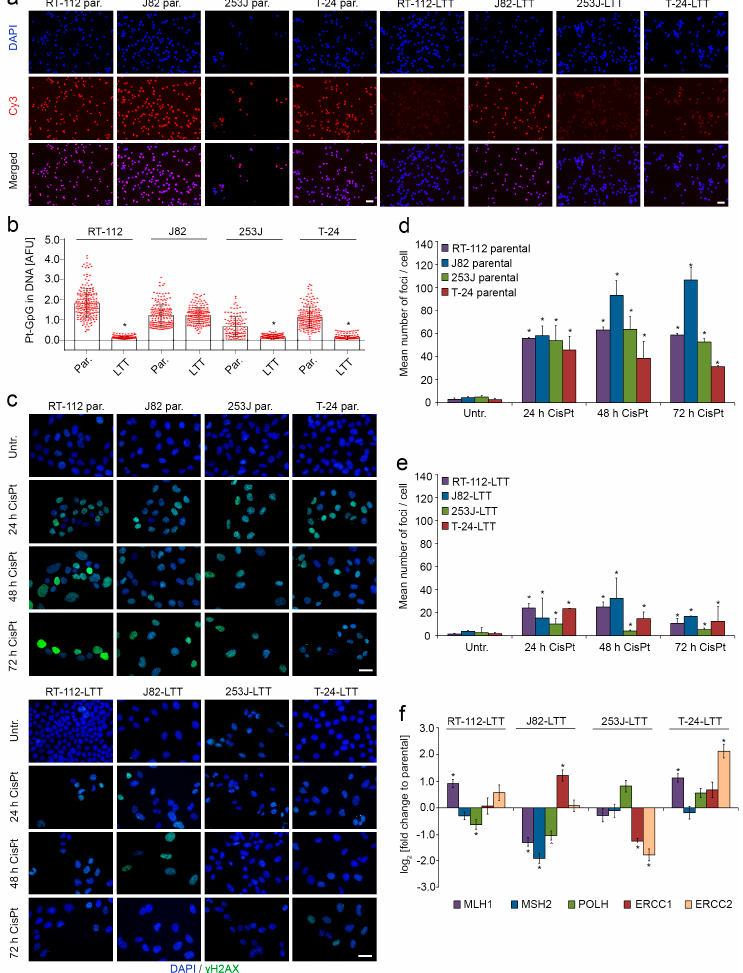
Figure 3. DNA-cisplatin adduct formation and extent of DNA damage are reduced in LTTs. ( a ) Representative immunofluorescence staining for Pt-adducts in parental UCCs and LTTs treated with 50 µM cisplatin for 4 h. Scale bar, 100 µm; ( b ) Quantification of Pt-adducts by immunofluorescent staining in parental UCCs and LTTs treated with 50 µM cisplatin for 4 h; ( c ) Representative immunofluorescence staining for pH2A.X (Ser139) foci in 24 h, 48 h, and 72 h IC 50 or maintenance cisplatin-treated parental UCCs and LTTs, respectively, compared to their untreated controls. Scale bar, 100 µm; Quantification of pH2A.X (Ser139) foci by immunofluorescent staining in UCCs ( d ) and LTTs ( e ) treated with IC 50 or maintenance cisplatin concentration, respectively, for 24, 48, and 72 h. Values represent the mean ± SD of biological duplicates; ( f ) Relative fold change of MLH1 , MSH2 , POLH , ERCC1 , and ERCC2 mRNA expression in LTTs was compared to their parental cell lines. Expression levels in the untreated parental cells were set as 1. For endogenous expression data of parental UCCs see Figure S1c. SDHA was used as a reference gene and relative expression was calculated by the 2 −ΔΔ C t method. Values represent the mean ± SD of three independent experiments. * p < 0.05, compared to untreated ctrl.